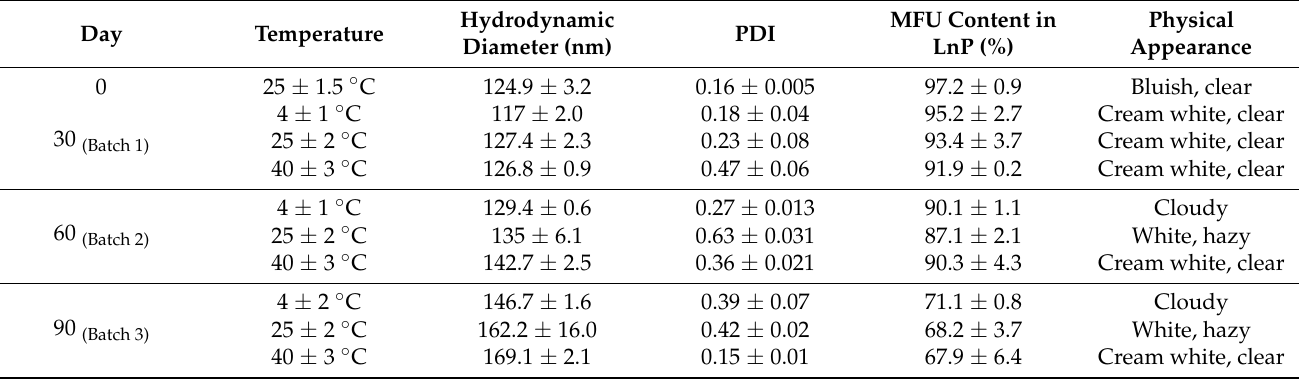
Table 2. Physical stability in terms of temperature effects, changes in hydrodynamic diameter, polydispersity index, MFU content, and physical appearance of